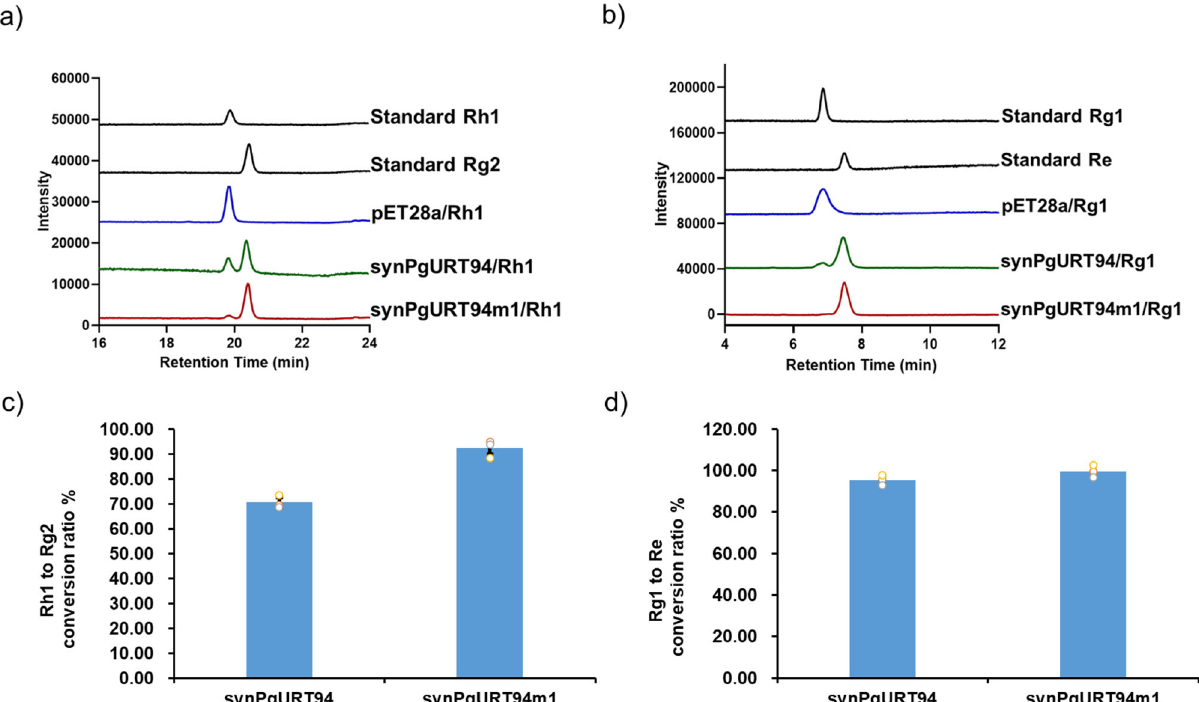
Fig. 4 Enzymatic assay of synPgURT94 and its mutant toward Rh1 or Rg1 as substrate. a , b HPLC analyses of the in vitro reaction products catalyzed by synPgURT94 and synPgURT94m1 crude enzymes using Rh1 ( a ) and Rg1 ( b ) as the sugar acceptor and UDP-rhamnose as the sugar donor. Crude enzymes of E. coli strain harboring pET28a empty vector were used as a negative control and authentic ginsenoside samples Rh1, Rg1, Rg1 and Re were monitored as standards. c , d Quantitative analysis of the conversion ratio catalyzed by synPgURT94 and synPgURT94m1, from Rh1 to Rg2 ( c ) and from Rg1 to Re ( d ). All data represent the mean of n = 3 biologically independent samples and error bars show standard